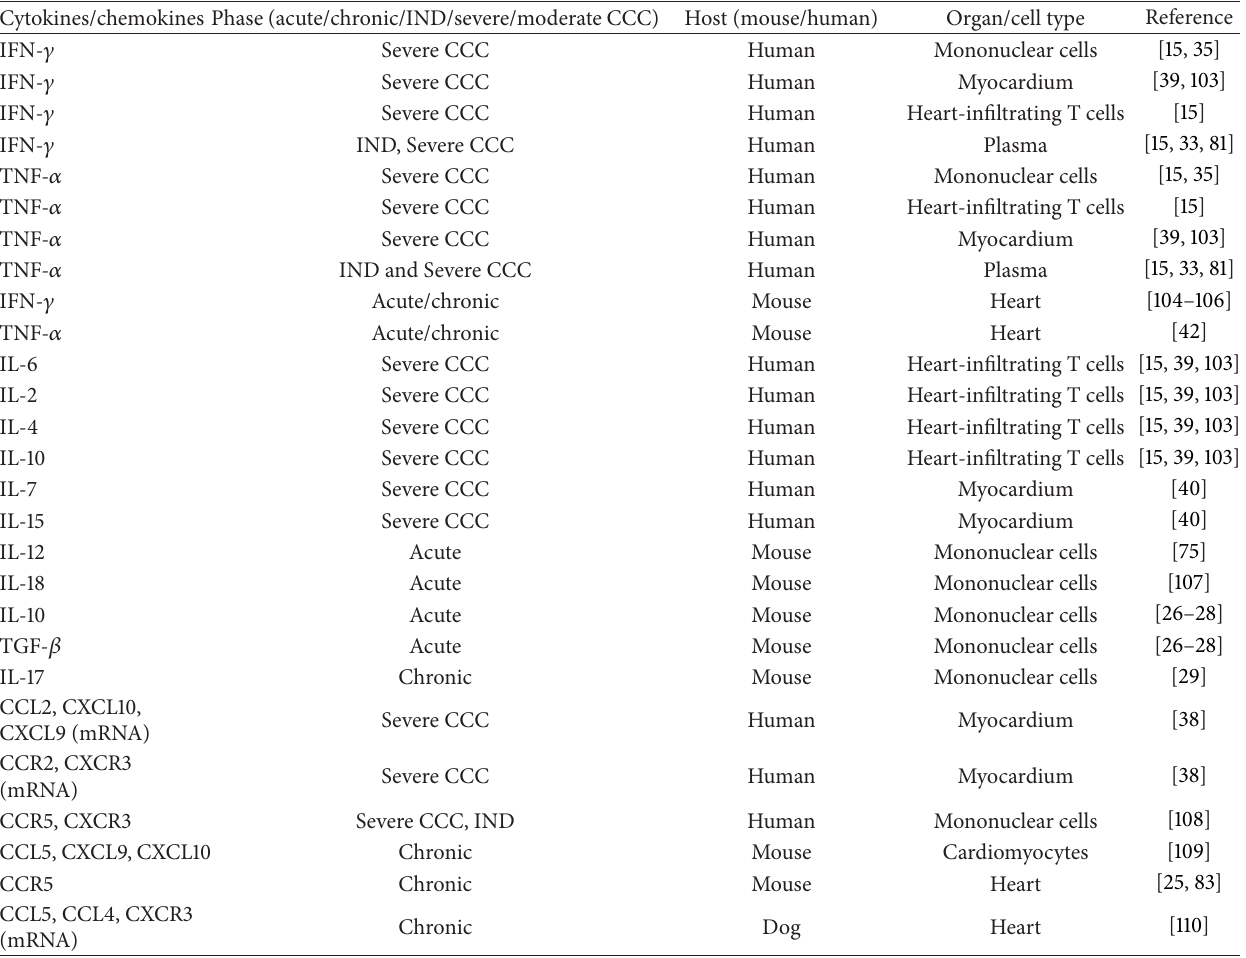
Table 1: Cytokine and chemokine expression in Chagas disease and animal